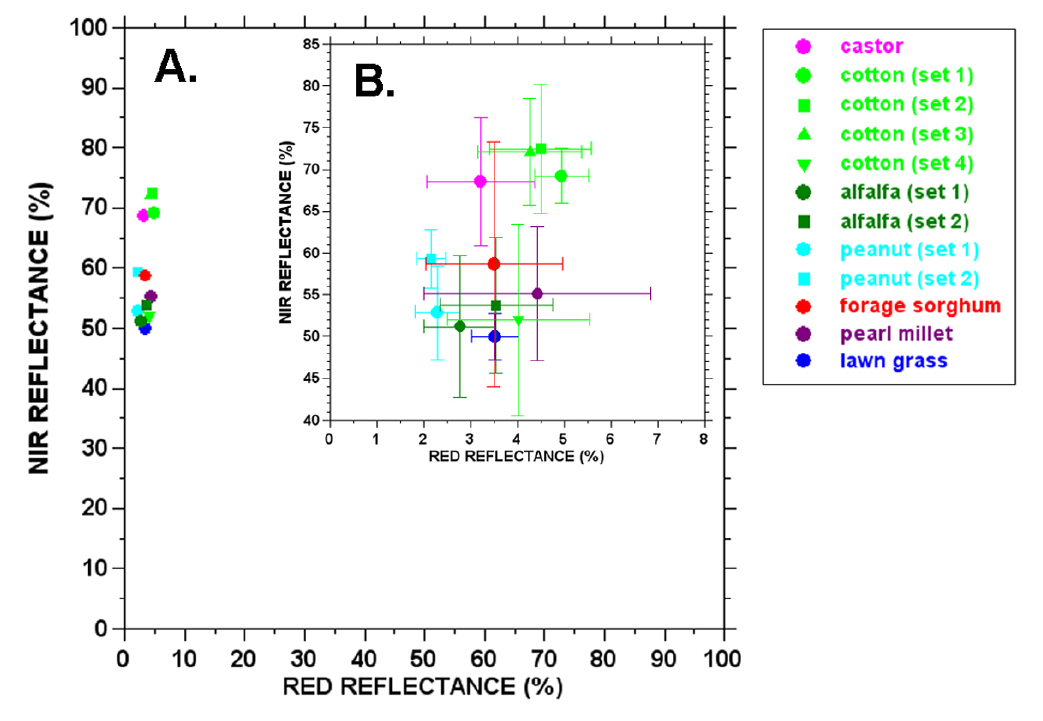
Figure 9. DC scatter plots for the May 13 and May 29 Landsat TM target